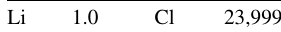
Initial concentration [mg/L]